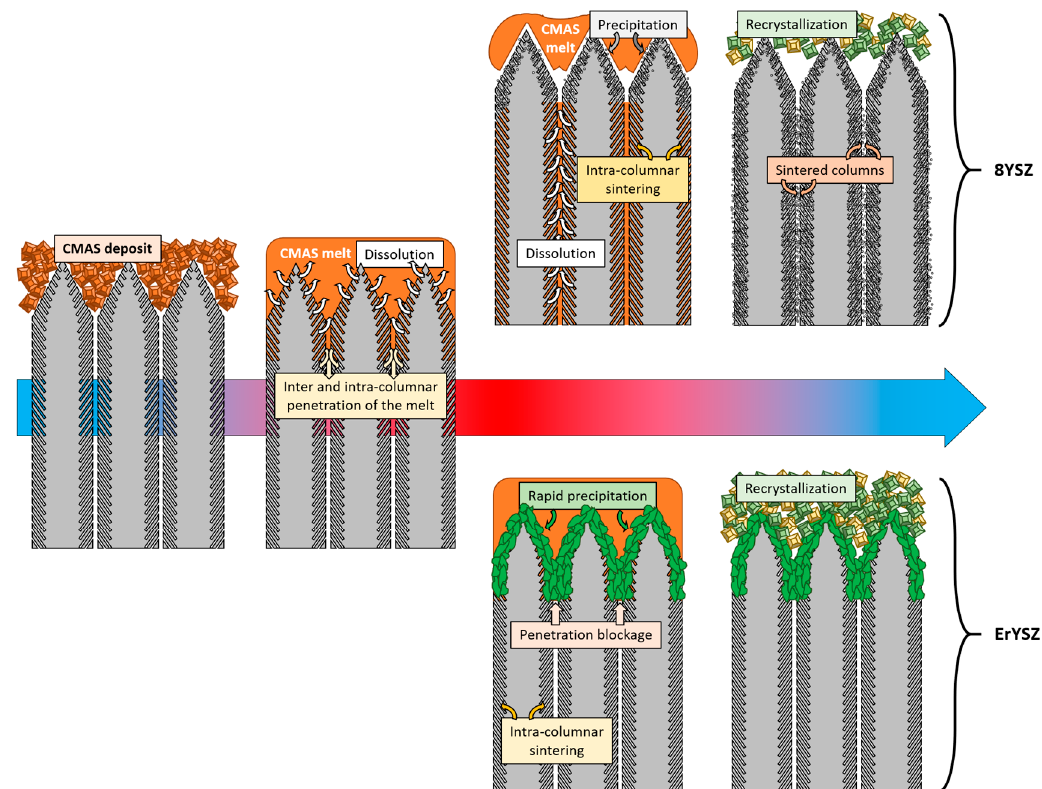
Figure 12. Schematic drawing of the CMAS interaction with the 8YSZ and ErYSZ columnar coatings during the annealing at 1250 °C (1 h) and final cooling.